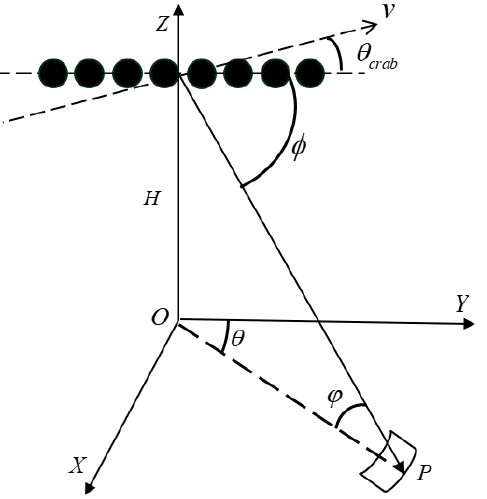
Figure 1. The geometry of uniform linear array airborne